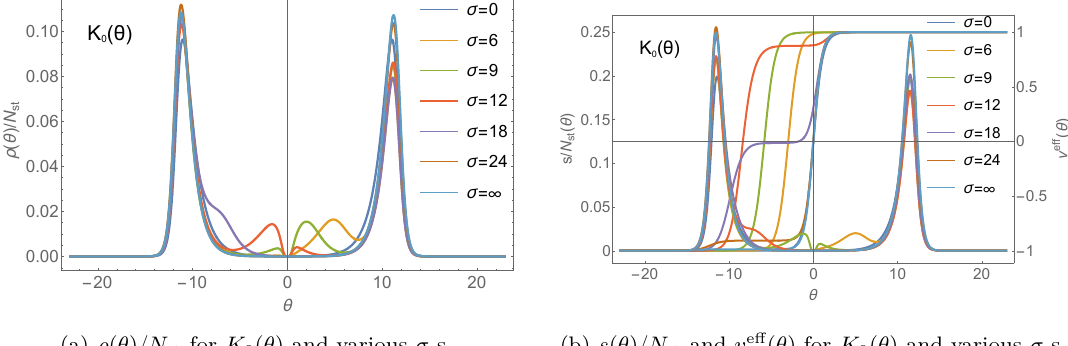
Figure 11 . The normalised spectral particle density divided by the total number of stable particles ρ p θ q{ N st (a) and the normalised spectral entropy density s p θ q{ N st with the effective velocity v eff p θ q (b) for fixed energy density and various σ parameters. We take β 2 . 8944 ˆ 10 ´ 5 , that is FF “ 2 log 2 { β 22 . 28 . The spectral densities now have a zero at θ “ 0 and the effective velocities FF “ develop a vanishing plateau around σ “ 2 log 2 { β . In inset (b) the left axis corresponds to FF s p θ q{ N st P r 0 , 0 . 25 s , and the right axis to v eff p θ q P r´ 1 , 1 s .